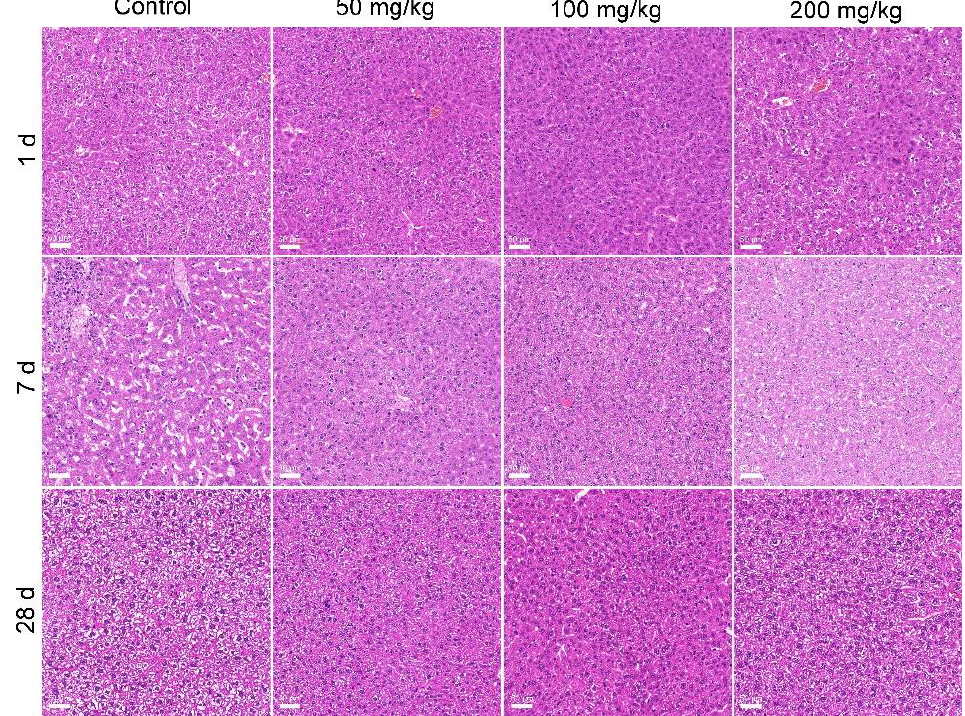
Figure 5. Histopathological observations of the liver after exposure to MOF-74(Co). The scale bar represents 50 μ m.